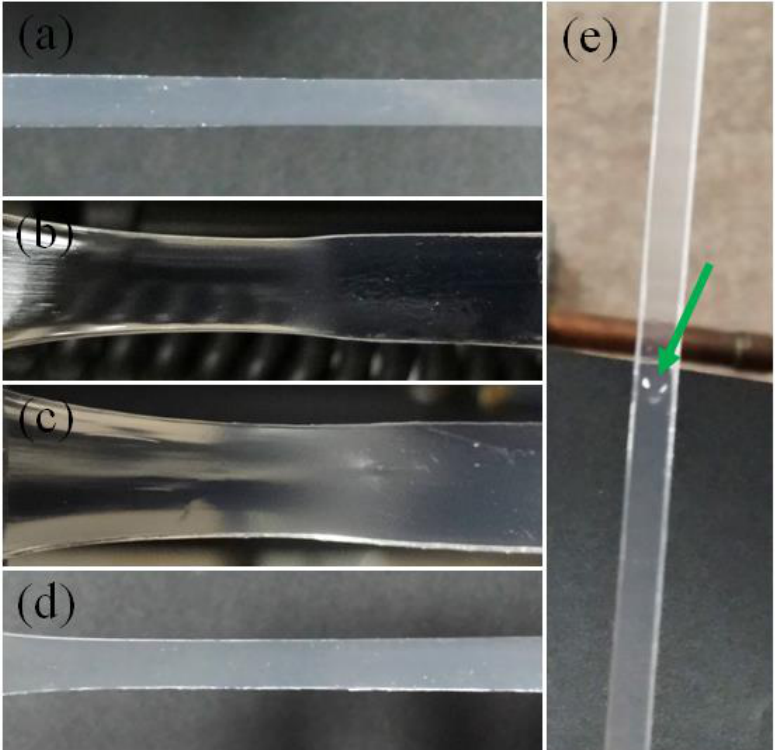
Figure 11. Appearance of DN hydrogels under tensile loading: ( a ): AMPS(1,1,4,9)/AAm(2,0.01,0.01,97); ( b ): SAPS(1,0.1,2,9)/AAm(2,0.1,0,97); ( c ): SAPS(1,2,2,9)/AAm(2,0.1,0,97); ( d ): SAPS(1,2,2,97)/AAm (2,0.1,0.05,97); ( e ): SAPS(1,4,2,9,PEO)/AAm(2,0.1,0.05,9). No consolidation was observed in case of conventional DN hydrogels made of second networks with very high molecular weight chains or chain strands. The sample synthesized by trapped PEO chains shows consolidation. Arrow shows a droplet of water falling down the surface of the gel during tensile loading. The consolidation is negligible, however, as compared to the water content of the